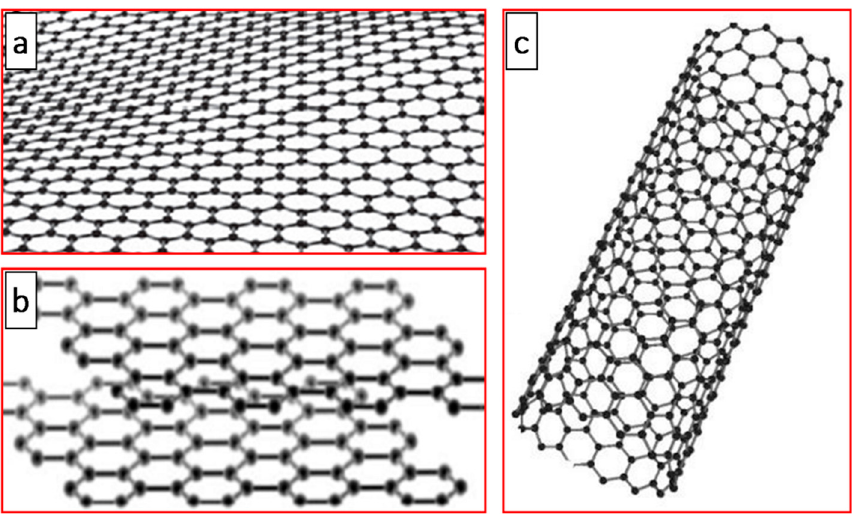
Figure 2. A conceptual model depicting the structure of graphene ( a ), graphite ( b ), and carbon nanotubes ( c ).